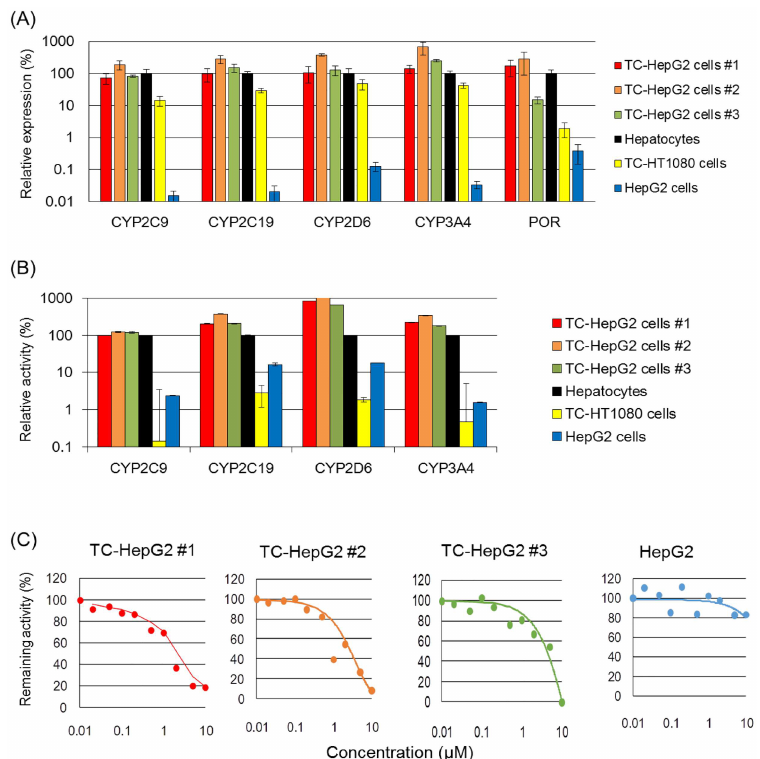
Fig 3. Analysis of CYP expression and activity in TC-HepG2 cells. (A) Reverse transcription-qPCR analysisfor the expression of CYPs in TC-HepG2 cells. Each column represents the mean ± S.D. ( n = 3). (B) CYP activity analysisin TC-HepG2 cells. The expressionand activity levels for each CYP relative to the levels in humanprimary hepatocytes are shown. Each column represents the mean ± S.D. ( n = 3). (C) CYP3A4 inhibitionactivity in TC-HepG2 cells determined by